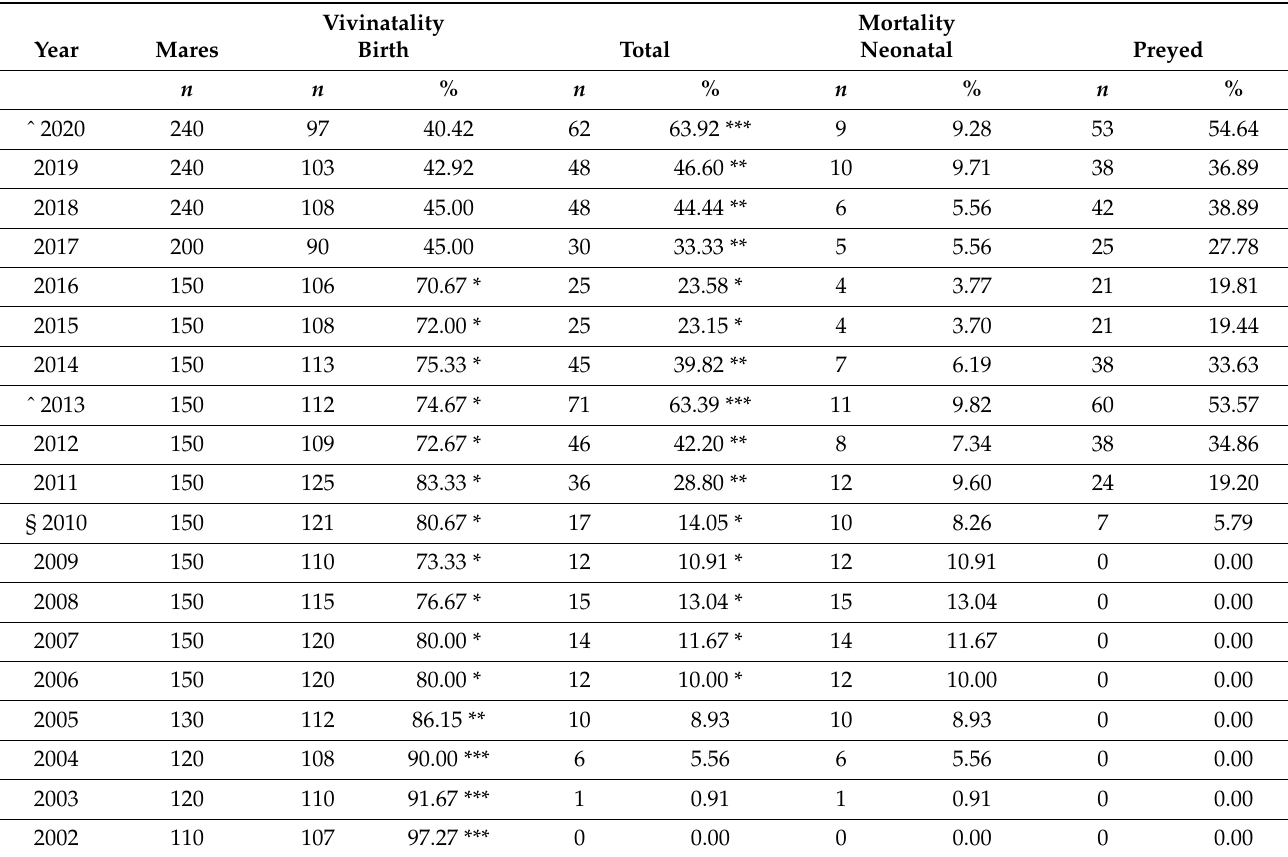
Table 6. Vivinatality of newborn foals; mortality numbers and percentage of Esperia’s ponies due to canid attacks in the period